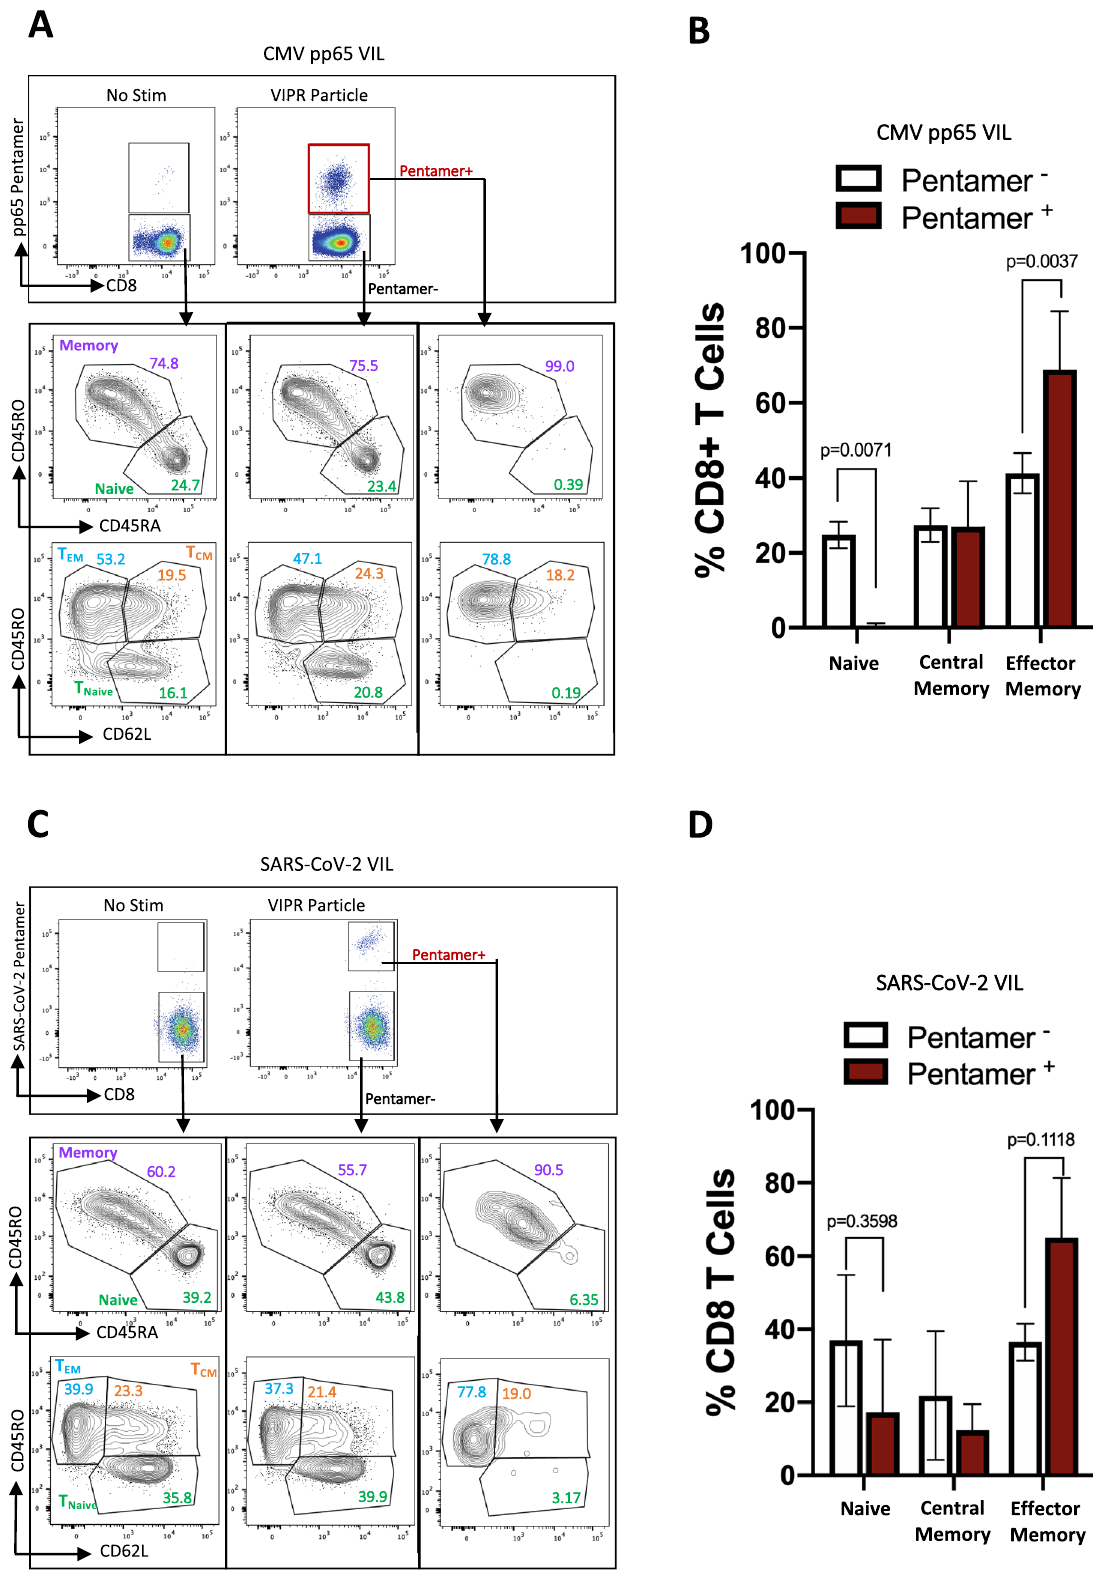
Figure 4. The T cell memory phenotype of rapidly-expanded CMV and SARS-CoV-2 antigen-specific VIL. ( A ) Representative flow-cytometric analysis showing expression of CD45RO, CD45RA and CD62L among enriched and expanded CMV-specific CD8 + T cells at day-7. ( B ) Summary of naïve, central memory and effector memory T cell subsets from data obtained in a, ( n = 4 ). ( C ) Analysis as in a, for SARS-CoV-2-specific CD8 + T cells, and ( D ) analysis as in b, for SARS-CoV-2-specific CD8 + T cells ( n = 8